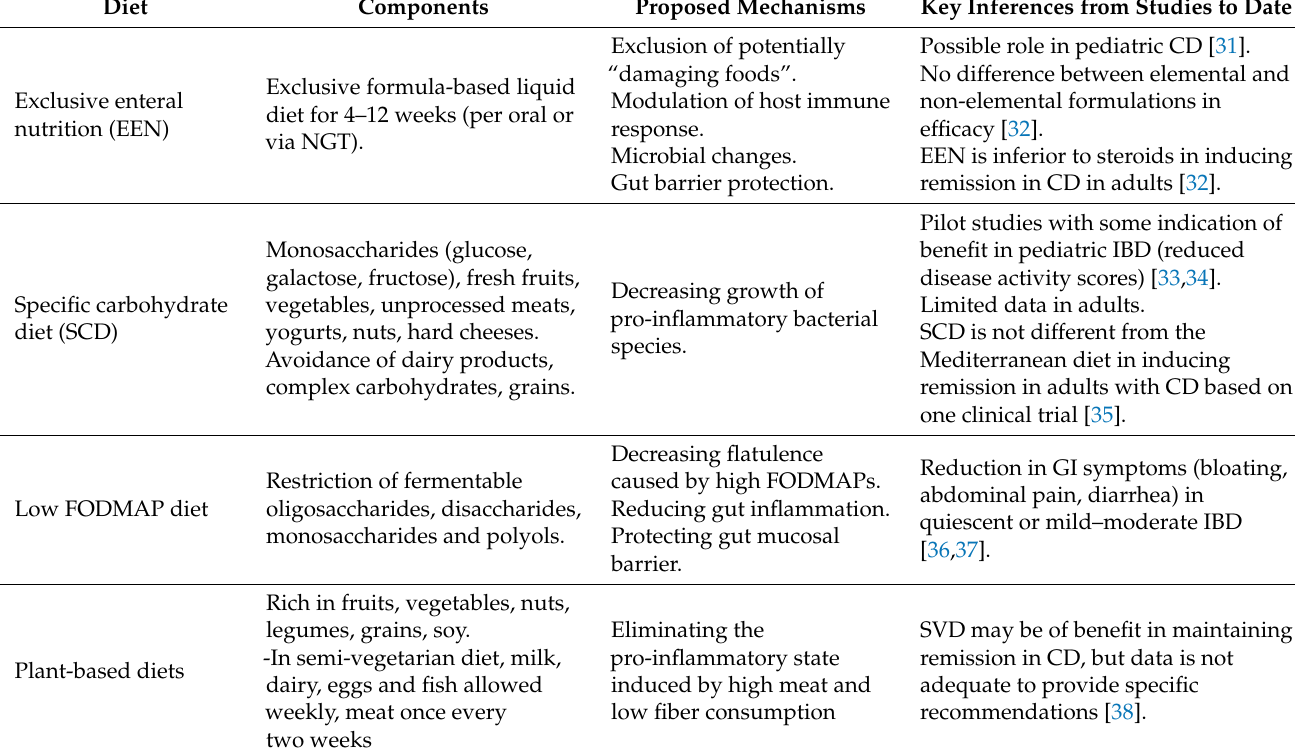
Table 1. Summary of evidence on commonly used diets in IBD and key take away